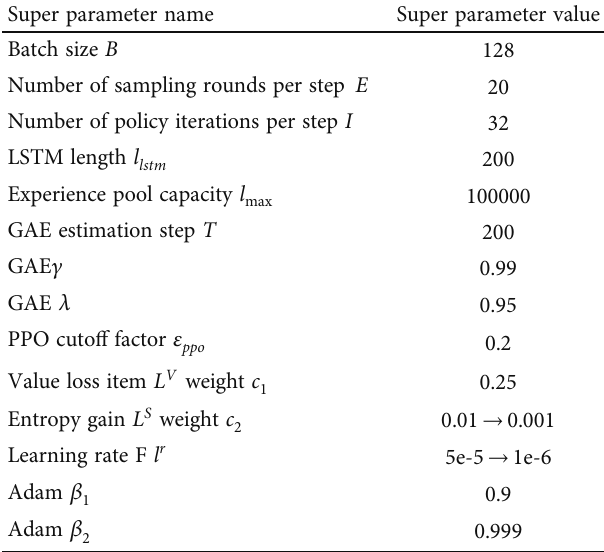
Table 5: Experimental super